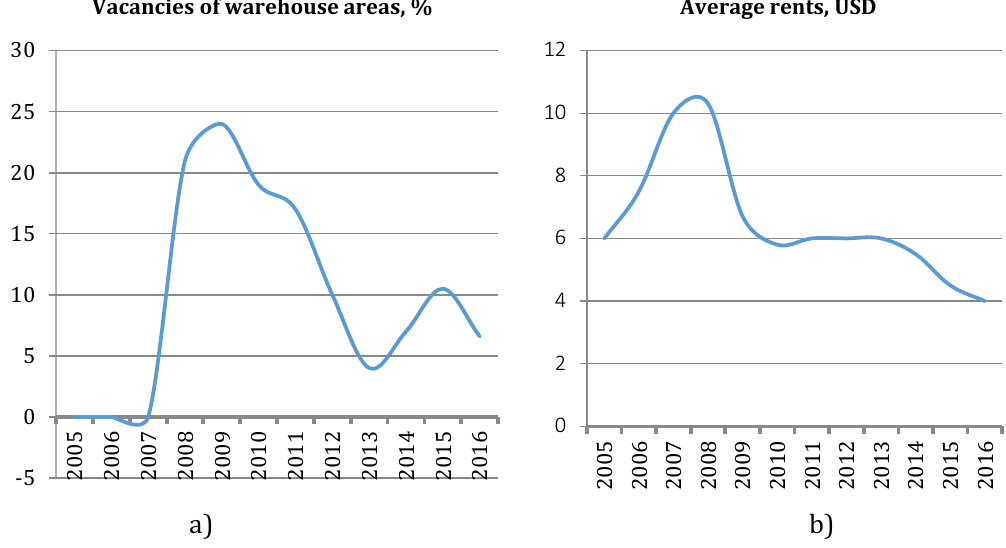
Figure 8: Dynamic trends in storage real estate